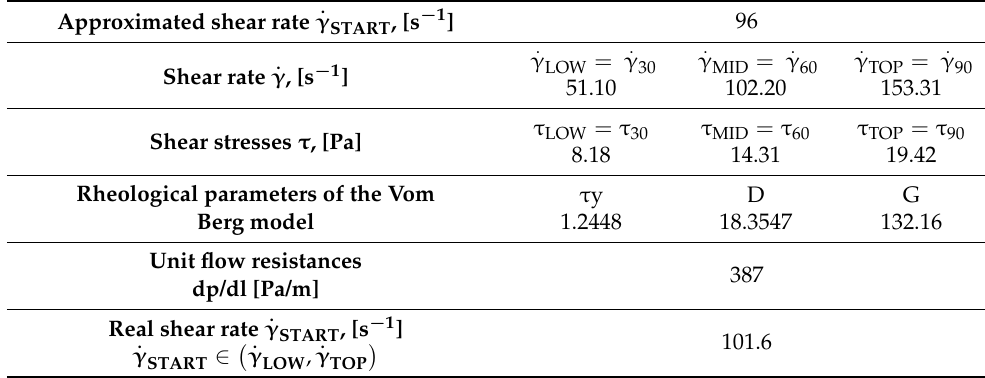
. γ . γ = . γ = . γ LOW 30 MID 60 153.31 = τ = τ = τ τ 30 τ MID 60 τ TOP 90 LOW τ y D G 132.16 387